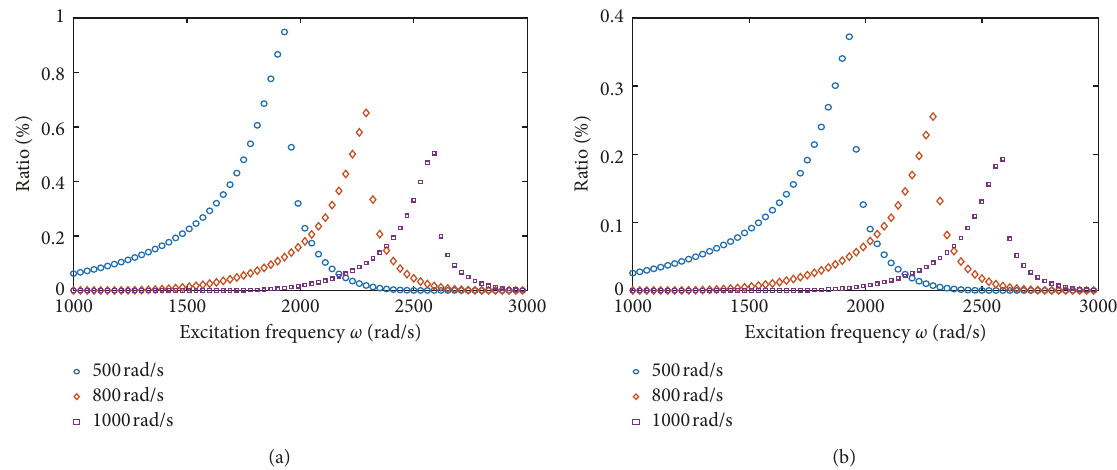
Figure 6: The energy ratio at different speeds. (a) Energy storage by contact force. (b) Energy consumption by friction force.